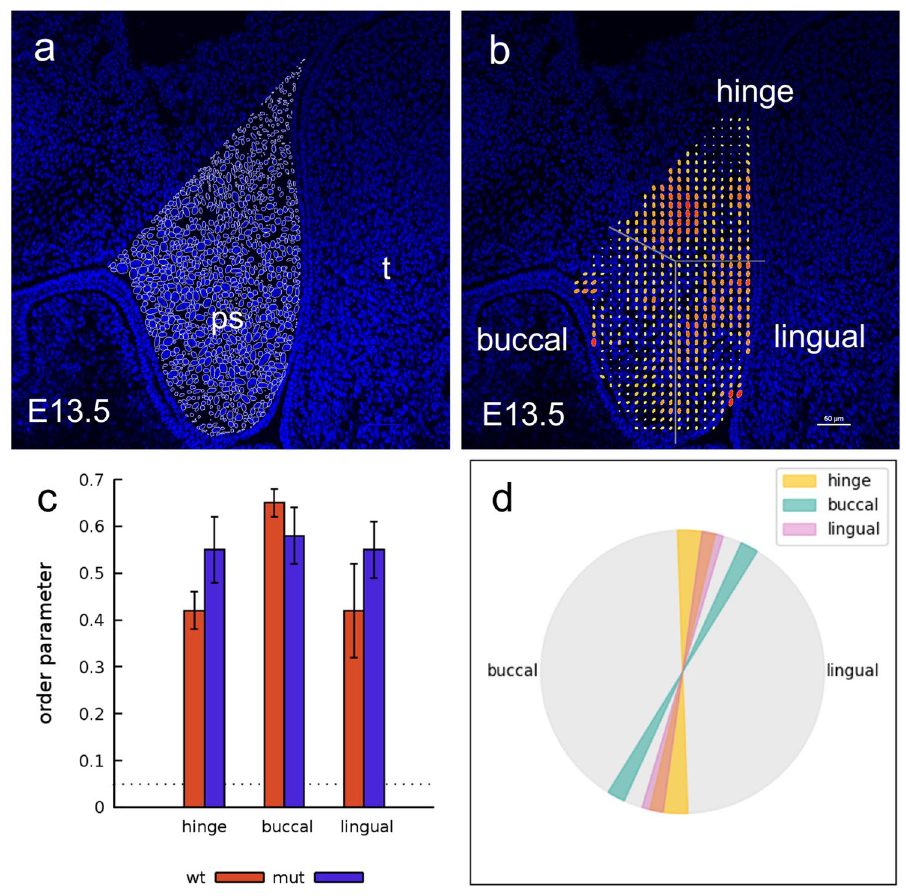
Figure 6. Mesenchymal cell alignment is observed in wildtype and mutant palatal shelves at E13.5. ( a ) Alignment of palate mesenchymal cells is shown by outlining DAPI-labeled nuclei within an epifluorescence micrograph of an E13.5 wildtype embryo palatal shelf (ps). Adjacent nuclei orientation appears in similar directions, and the local prevalent directionality is indicated by yellow lines. t = tongue. ( b ) Adjacent nuclei tend to orient in similar directions, which is quantified by a local order parameter, represented as ellipses. The size of the symbols and warmer colors indicate a greater degree of orientation, while the long axis of the ellipses indicate the prevailing local orientation of nuclei. To statistically characterize the spatial orientation of nuclei across multiple specimens, we distributed the palatal shelves into three regions (hinge, lingual and buccal), as indicated. ( c ) Average alignment of nuclei in the hinge, buccal and lingual regions for wildtype (n = 4) and mutant embryos (n = 4). The dotted line indicates the 99% confidence interval for the null hypothesis assuming independent, uniformly distributed random nuclear orientation. Thus, presented values indicate a statistically significant order (p < 0.001, n = 4), while the differences between regions and between wildtype and mutant embryos is not significant. ( d ) The prevailing orientational order is parallel with the palatal shelf, but it becomes tilted toward the tongue in the buccal region. The difference in orientation is significant (p = 0.005 and p = 0.012 for the buccal vs lingual (p < 0.005) and buccal vs hinge (p < 0.012)